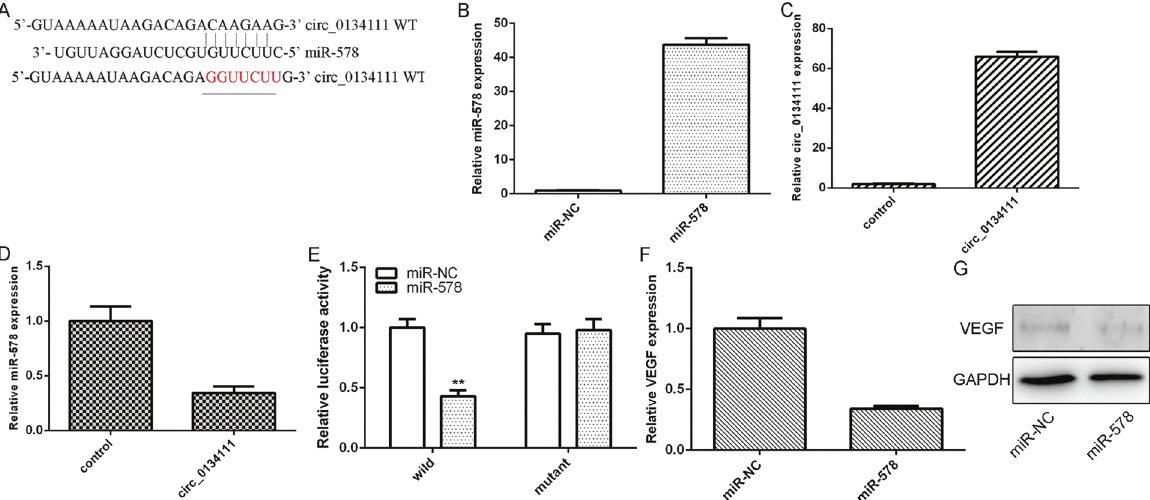
Fig. 3 circ_0134111 directly interacted with miR-578 in NP cells. A miR-578 harbored a circ_0134111-binding site as predicted using bioinformatics. B The expression of miR-578 was upregulated in NP cells after transfection with miR-578 mimic. C The circ_0134111 expression was increased in NP cells after transfection with pcDNA-circ_0134111 vector. D Enforced expression of circ_0134111 reduced miR-578 expression. E The luciferase activity of wild-type but not the bind site-mutated circ_0134111 was downregulated upon transfection with miR-